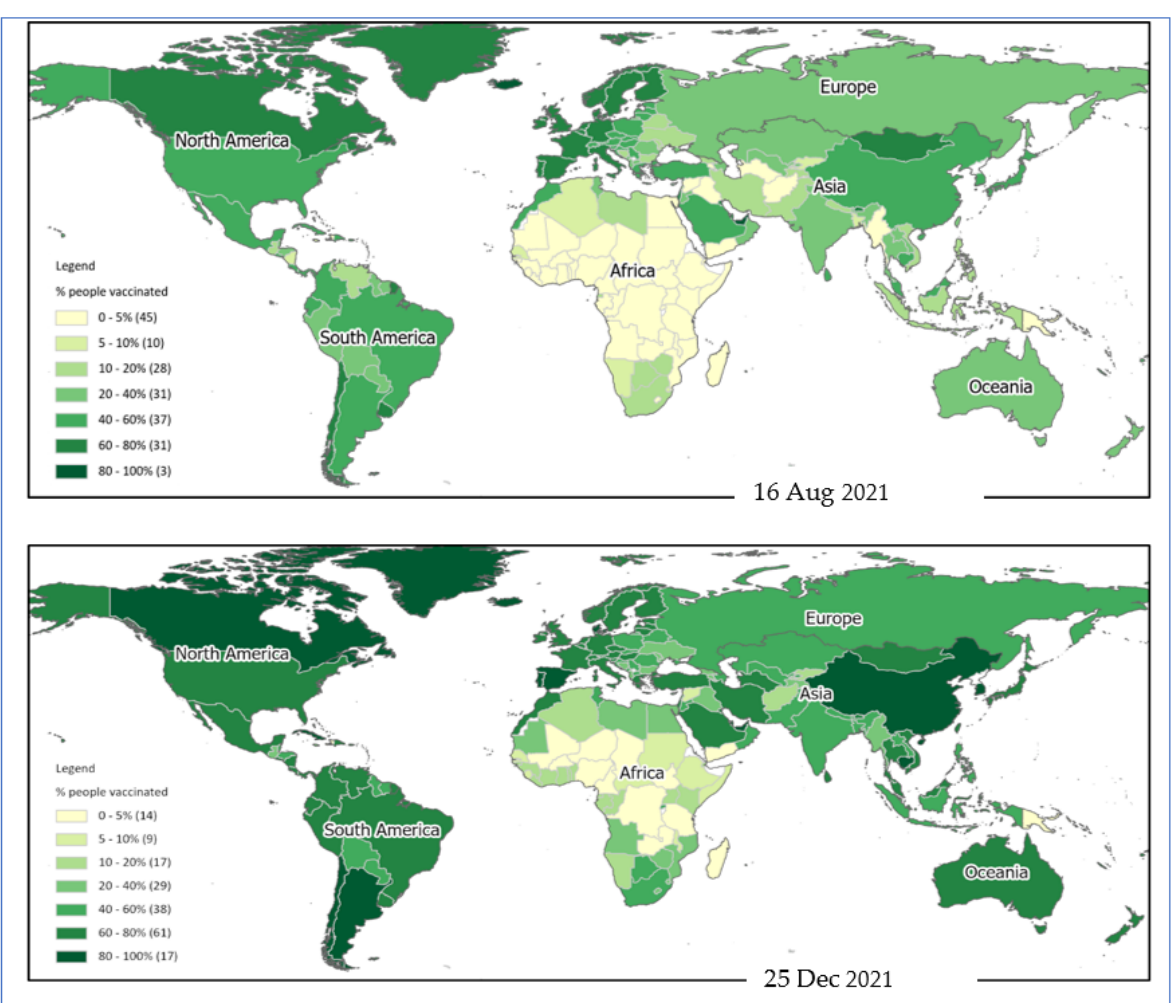
Figure 6. Spatial distribution pattern of COVID-19 vaccination during August and December 2021.